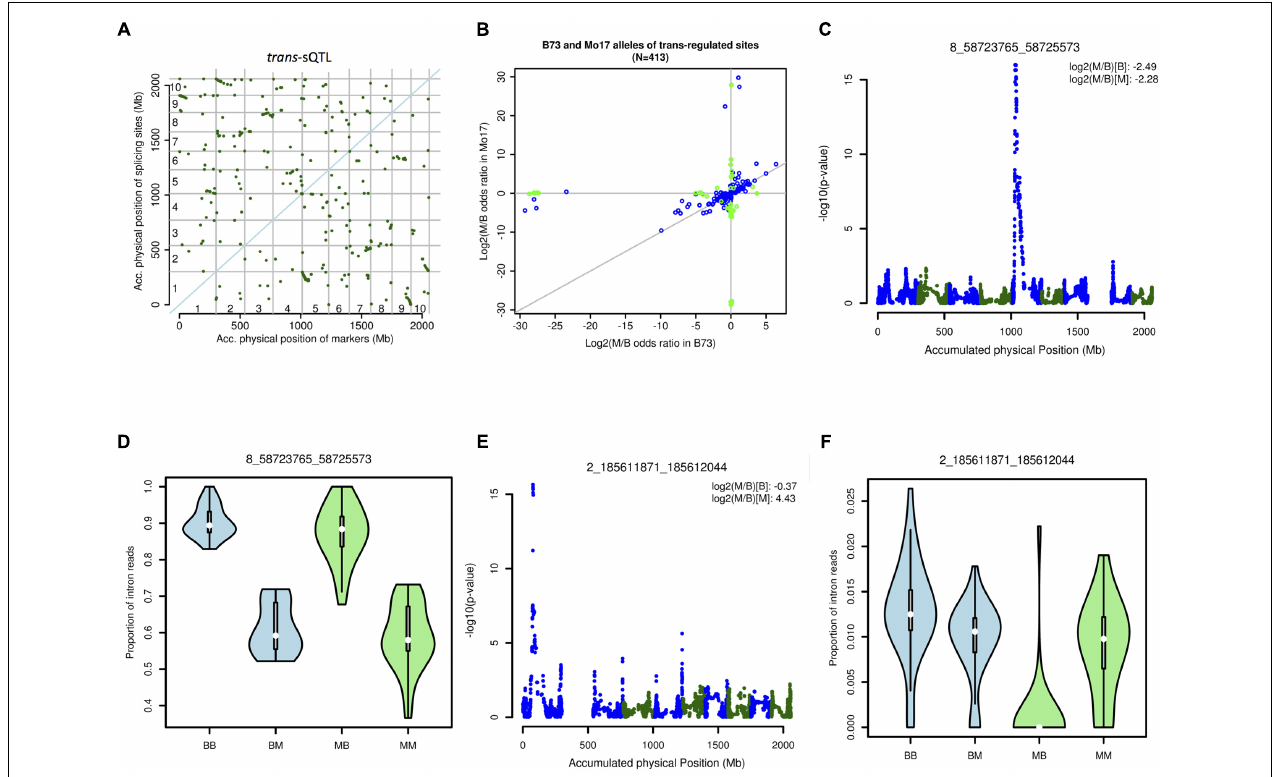
FIGURE 7 | Trans -sQTL analysis. (A) Distribution of trans- sQTL on the maize chromosomes. (B) Interaction between the marker and the junction. Blue: significant trans- effect but not significant cis- trans- interaction. Green: significant trans- effect and significant cis- trans- interaction. (C) QTL peak associated with the splice junction chr8_58723765_58725573. (D) Expression patterns for junction chr8_58723765_58725573 associated with four different allelic contributions (two alleles for the marker and two alleles for the junctions, the first letter represents the allele for marker and the second letter represents the allele for junction): BB, BM, MB, and MM. (E) QTL peak associated with the splice junction chr2_185611871_185612044. (F) Expression patterns for splice junction chr2_185611871_185612044 associated with four different allelic contributions two alleles for the marker and two alleles for the junctions, the first letter represents the allele for marker and the second letter represents the allele for junction): BB, BM, MB, and